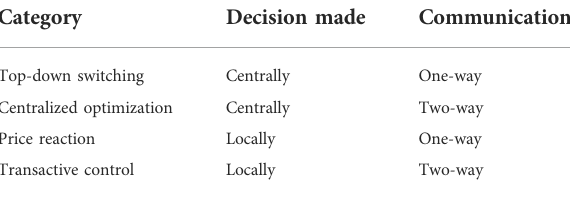
TABLE 4 Four main categories of energy management.